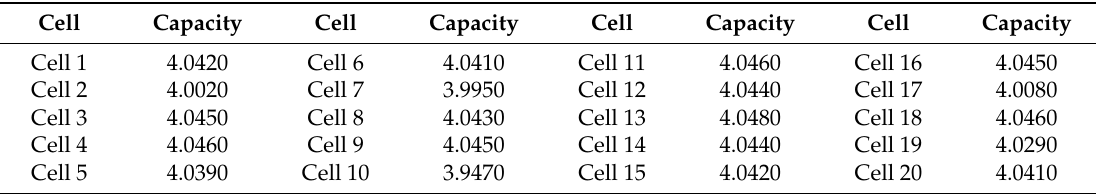
Table 4. ˆ U k ( 1200 ) of 20